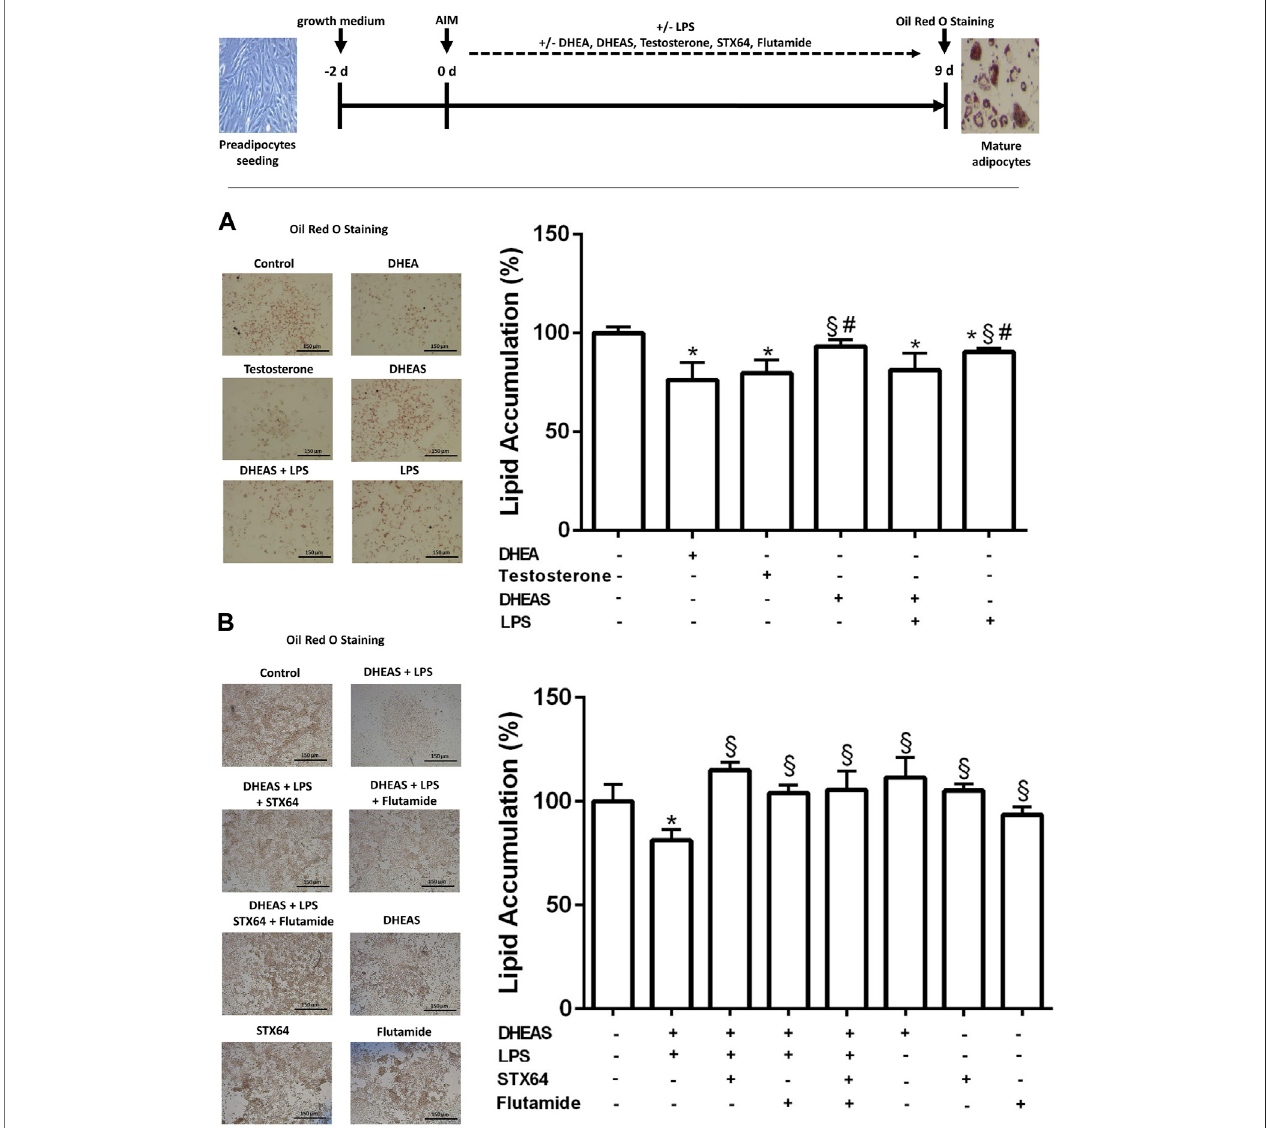
FIGURE 5 | Effect of DHEAS on lipid accumulation in LPS-induced 3T3-L1 adipocytes. Scheme of the experimental procedure for 3T3-L1 differentiation from preadipocytes to mature adipocytes over 9 days and cell treatment. Cell differentiation was induced by hormonal supplementation (AIM) as described in the Materials and Methods section. 3T3-L1 preadipocytes were incubated with DHEA (1 µM), testosterone (100 nM), DHEAS (10 µM), STX64 (10 µM), or fl utamide (1 µM) in the presence or absence of LPS for the entire 9-day differentiation period, and every 2 days the medium was changed with fresh AIM containing the respective compounds.Onday9,thecellswerestainedwithOilRedO.RepresentativephotomicrographsofOilRedOstaininginmature3T3-L1adipocytesareshown(scalebar: 150 μ m). Lipid accumulation was measured by Oil Red O extraction and quanti fi cation using a microplate reader. Data are expressed as mean ± SD of three replicates from (A) three independent experiments and from (B) one representative experiment. Signi fi cant differences are indicated by p < 0.05 using one-way ANOVA with Tukey ’ s multiple comparisons test: *signi fi cantly different compared to control; § signi fi cantly different compared to LPS + DHEAS; # signi fi cantly different compared to DHEA and testosterone. AIM, adipogenesis-inducing